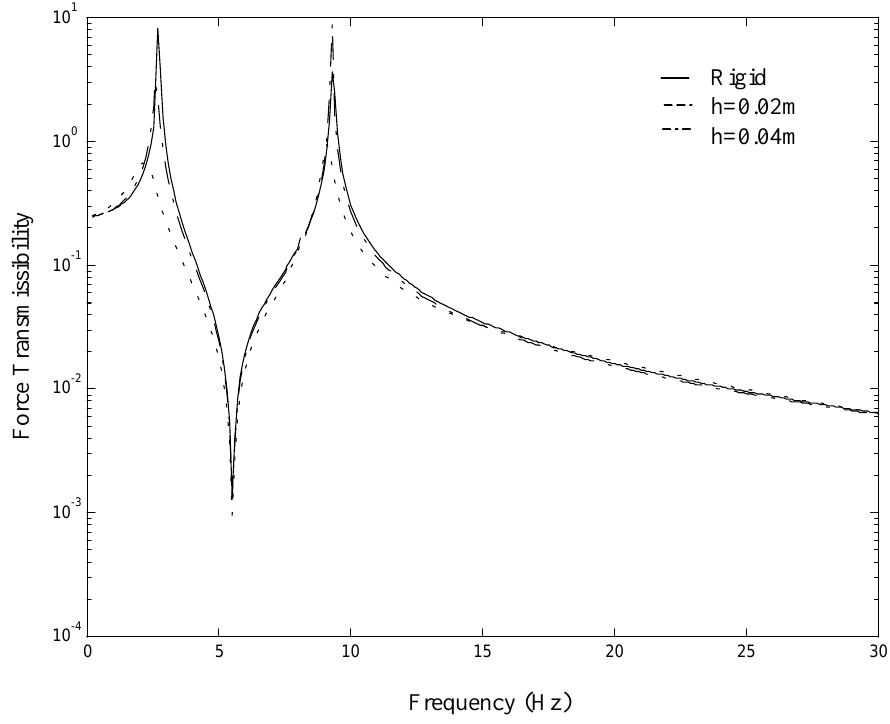
Fig. 7. Vertical force transmission at mount 1-infinite plate with heavy fluid loading under the unit moment excitation around z-axis at c.g. of rigid